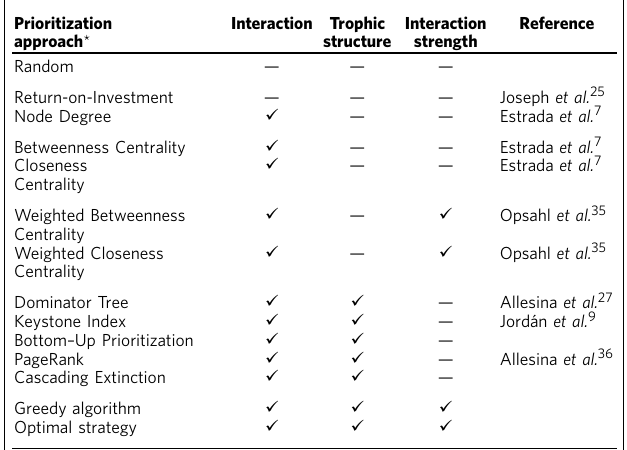
Table 1 | Summary of food-web complexities incorporated by each approach.